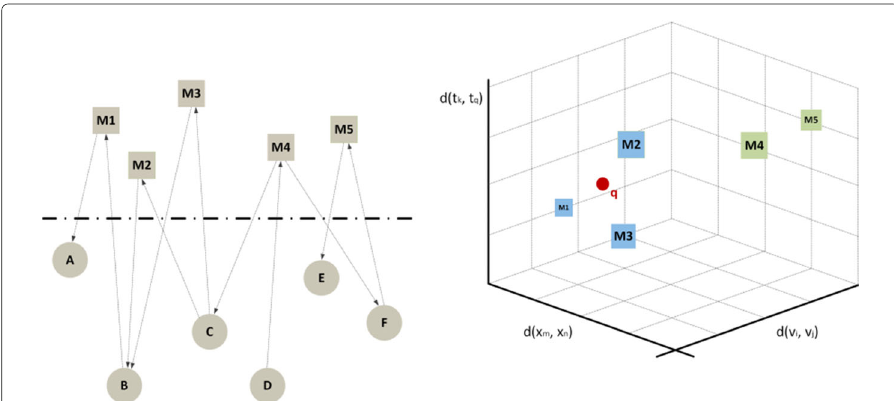
Fig. 7 Continuous approach: embedding. ( left ) A temporal text network with 6 actors — circles — and 5 messages — squares; ( right ) the messages have been grouped into two clusters based on their topological,